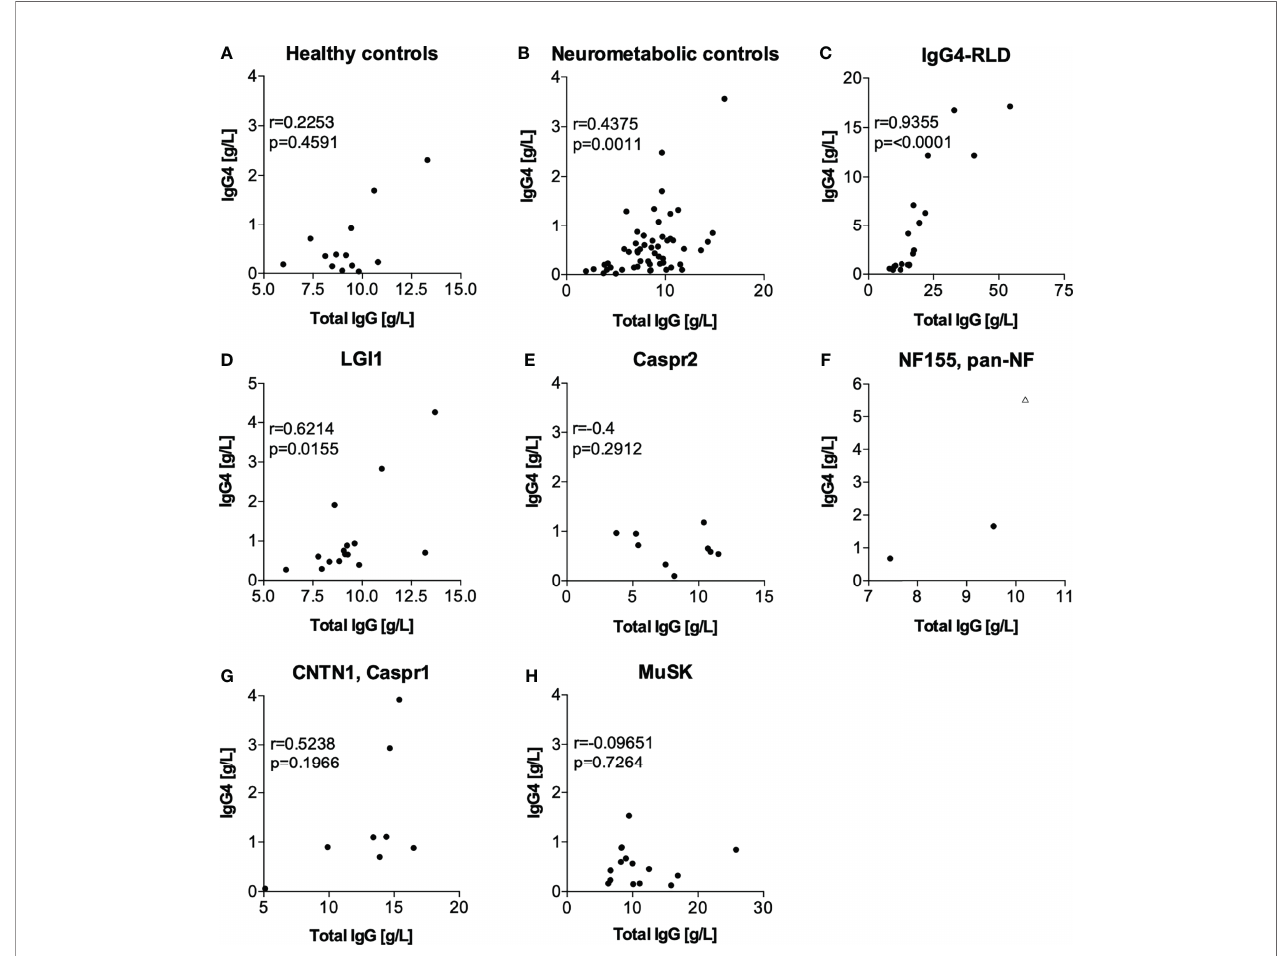
FIGURE 3 | Correlation between serum IgG4 and total IgG concentrations (statistical analysis with Spearman correlation in datasets with at least 3 datapoints). (A) healthy controls, (B) neurometabolic controls, (C) IgG4-RLD, (D) LGI1, (E) Caspr2, (F) NF155, (G) CNTN1, Caspr1 and (H) MuSK. In (F) , the triangular data point indicates a patient that was excluded from the statistical analysis due to the presence of pan-NF antibodies instead of NF155 antibodies and severe concomitant autoimmune diseases. Caspr1, contactin-associated protein-like 1; Caspr2, contactin-associated protein-like 2; CNTN1, contactin 1; IgG, immunoglobulin type G; IgG4, immunoglobulin type G subclass 4; IgG4-RLD, IgG4-related disease; LGI1, leucine-rich glioma inactivated protein- 1; MuSK, muscle-speci fi c kinase; NF155, neurofascin